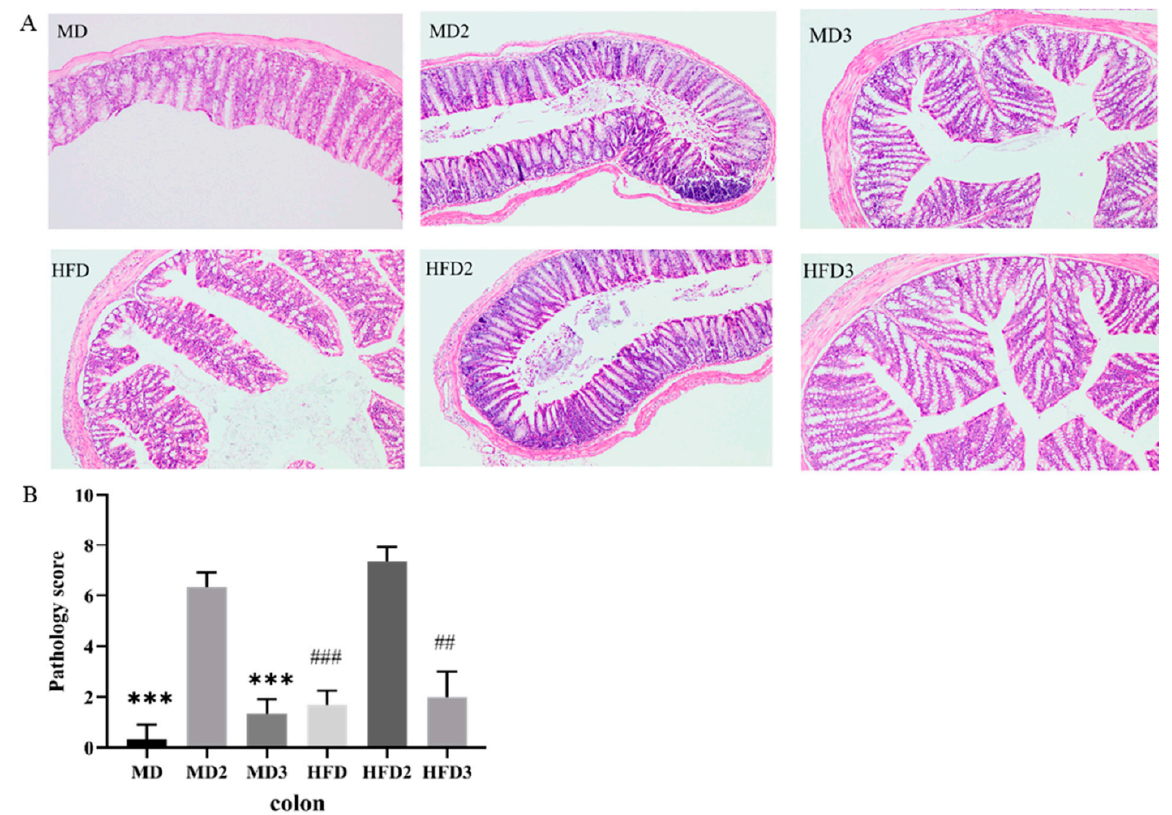
Figure 2. L. plantarum 1201 alleviates the intestinal injury induced by S. Typhimurium ATCC 13311. ( A ) hematoxylin-eosin staining (HE) pathological section of mouse colon tissue; ( B ) Colon